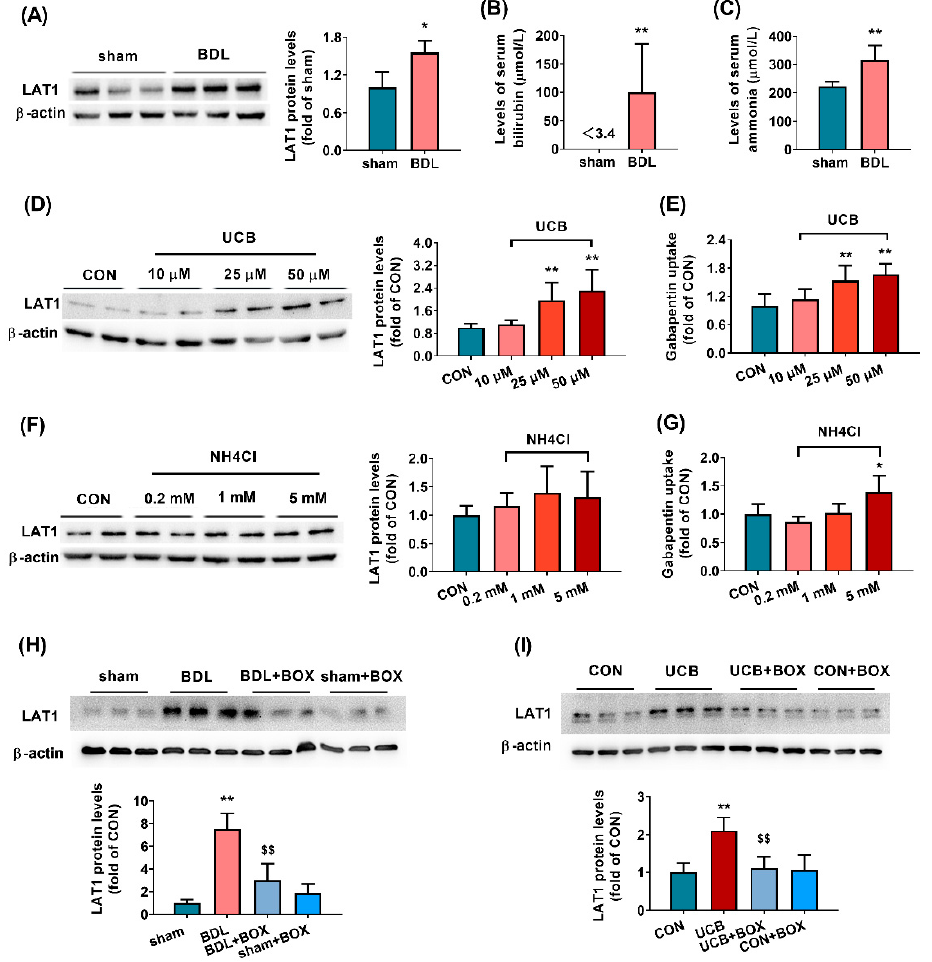
Figure 2. Effects of potential factors on the expression and function of LAT1 in HCMEC/D3 cells. Effects of serum from BDL rats on the expression of LAT1 ( A ). The levels of bilirubin ( B ) and ammonia ( C ) in serum of BDL and sham rats. Effects of unconjugated bilirubin (UCB) on expression ( D ) and function (uptake of gabapentin, ( E )) of LAT1 protein. Effects of NH 4 Cl on expression ( F ) and function (uptake of gabapentin, ( G )) of LAT1 protein. Effects of serum from BDL and sham rats in absence and presence of bilirubin oxidase (BOX) on protein levels of LAT1 in HCMEC/D3 cells ( H ). Effects of UCB and BOX on protein levels of LAT1 ( I ). Data are presented as the mean ± SD ( n = 6). * p < 0.05 and ** p < 0.01 versus sham rats or control (CON) cells. $$ p < 0.01 versus BDL rats or UCB treated group.